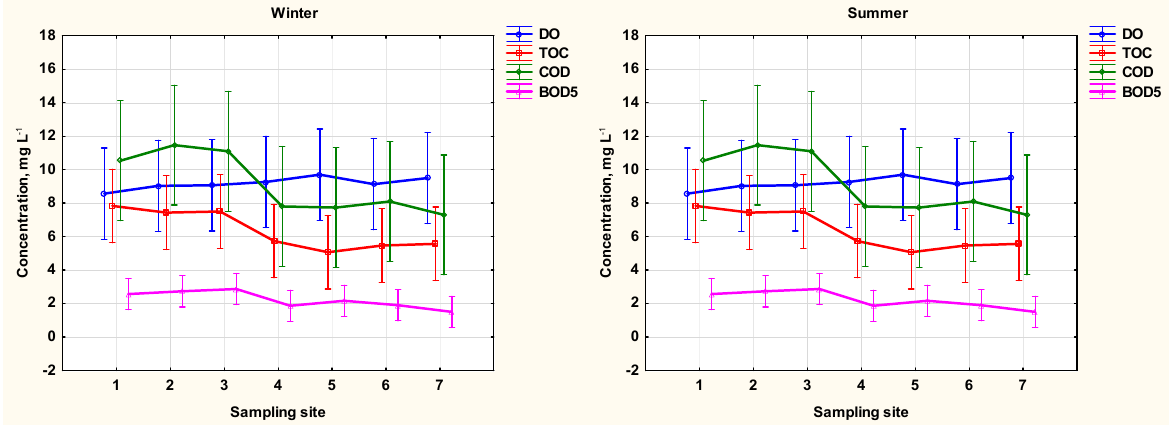
Figure 3. The distribution pattern of the dissolved oxygen and organic matter concentrations at Lake Gusinoe during the year.